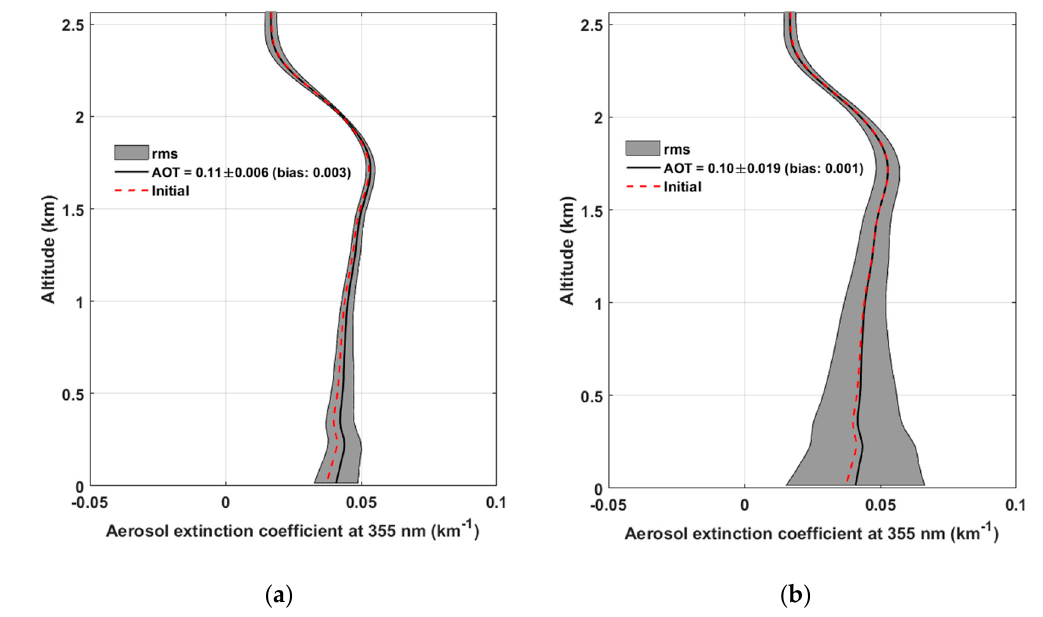
Figure 12. Vertical profiles of the aerosol extinction coefficient (AEC) retrieved using the Monte Carlo approach for flight strategies: ( a ) on two flight altitude levels and ( b ) on a single flight altitude level. The initial value is given by the red dotted line, the mean AEC retrieval is given by the black continuous line. The standard deviation (rms) is highlighted in gray.